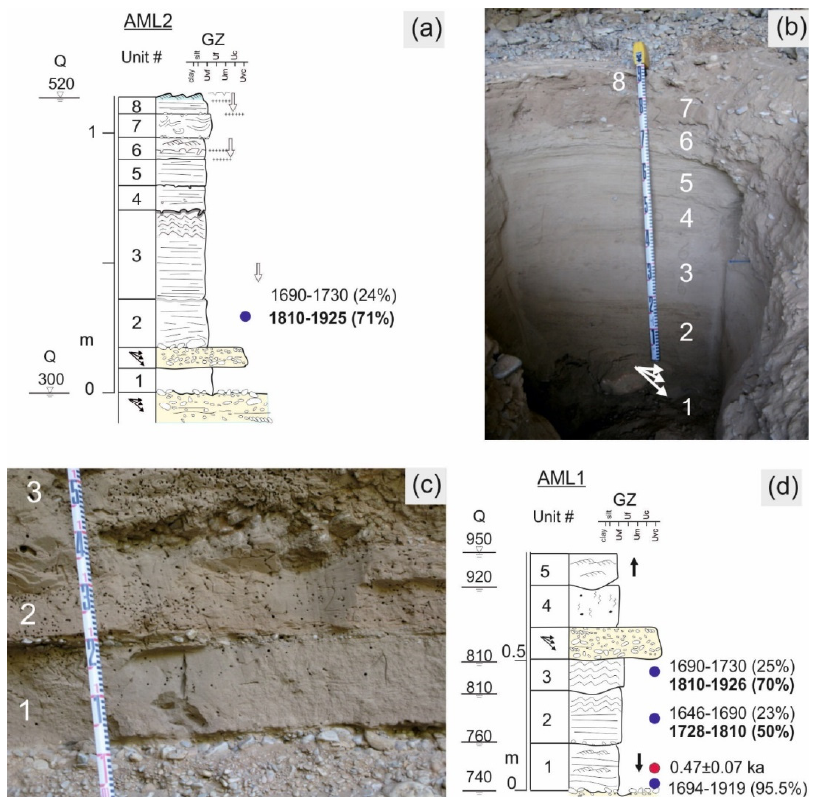
Figure 7. ( a ) Stratigraphic profile AML2 with indication of flood units and age dating results. ( b ) View of AML2 stratigraphy. ( c ) Stratigraphic log AML1. ( d ) View of AML1 profile.